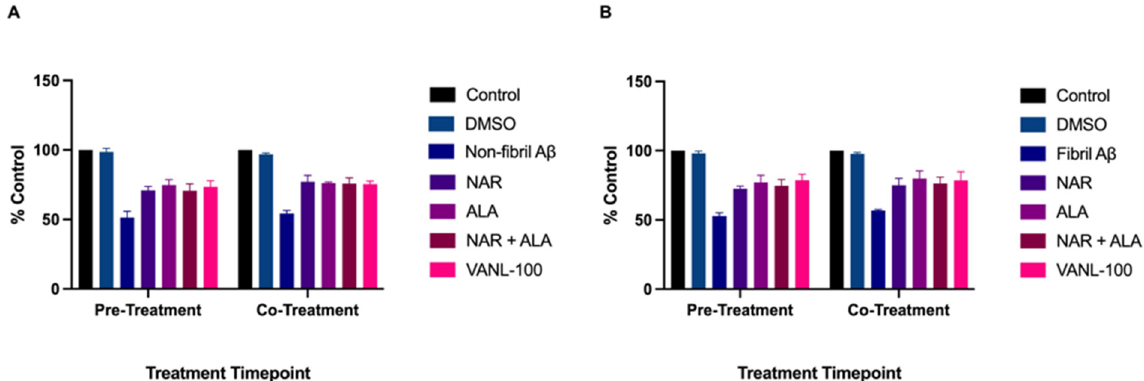
Figure 7. Effect of antioxidant treatment timepoint on overall cell survival. Cell viability, represented as % control, is shown on the y-axis, and antioxidant treatment time is displayed on the x-axis. The bars represent the mean ± SEM of three independent experiments. ( A ) Comparison of pre-treatment and co-treatment of antioxidants in combination with non-fibril A β 25–35 . ( B ) Comparison of pre-treatment and co-treatment of antioxidants in combination with fibril A β 25–35 . Statistical significance of pre-treatment vs. co-treatment was assessed using two-way ANOVA. p < 0.05.